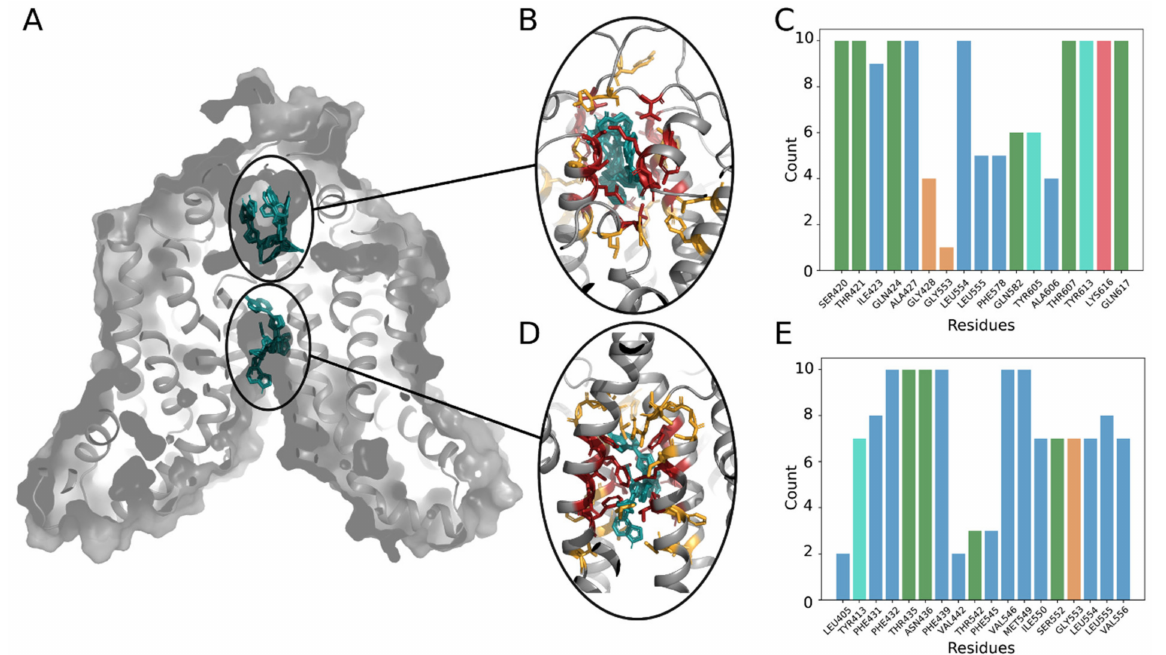
Figure 7. Ruxolitinib docking to the ABCG2 model. ( A ) General view of the ABCG2 dimers’ structure with two main binding sites (extracellular and intracellular cavities) and 10 best binding poses of a ligand (shown in cyan). ( B , D ) Close view at the main binding sites: residues contacting with a ligand in all 10 poses are colored in red, residues interacting with the ligand only in several positions are colored in yellow. ( C , E ) Number of interactions detected between ruxolitinib and residues in the 10 best positions. Bars are colored according to the standard Clustal X color scheme: blue for hydrophobic, green for polar, red for positively charged residues, orange for glycine, and cyan for